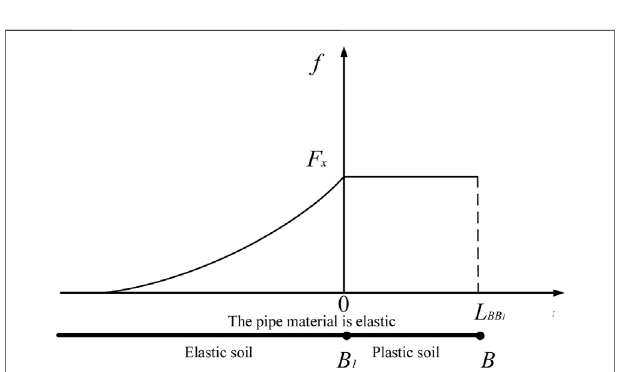
FIGURE 8 | The distribution of soil reaction forces in the tension section of the pipeline at the stage II.